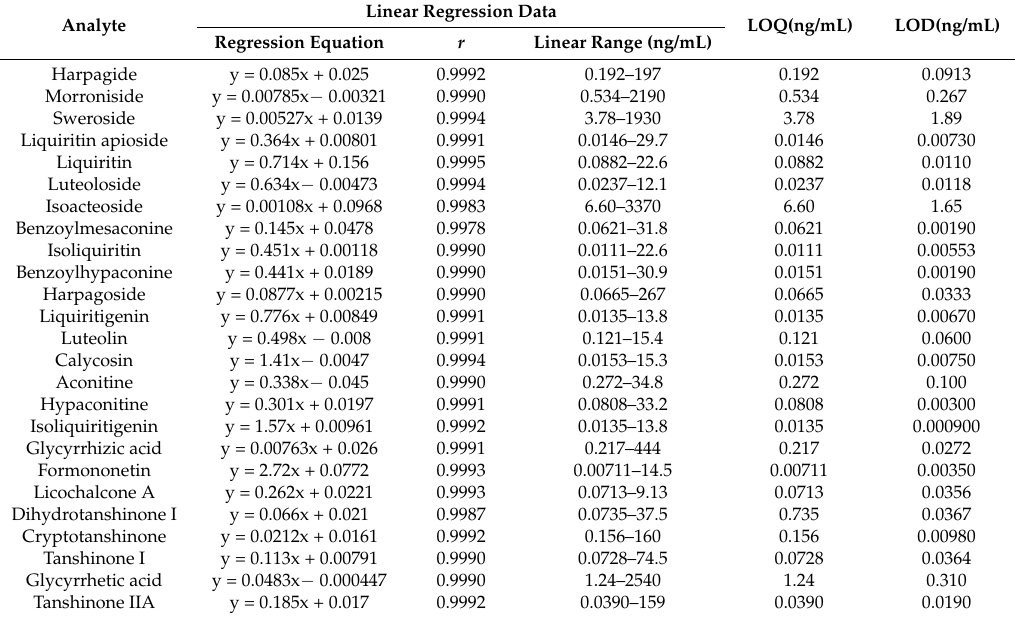
Table 2. Regression equations, linear ranges, LOQs, and LODs of the twenty-five analytes.